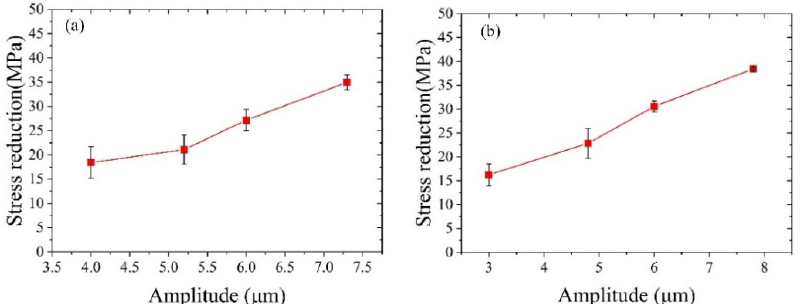
Figure 16. The magnitude of the stress reduction under different amplitudes of ultrasonic vibration: ( a ) 20 kHz, and ( b ) 28 KHz.